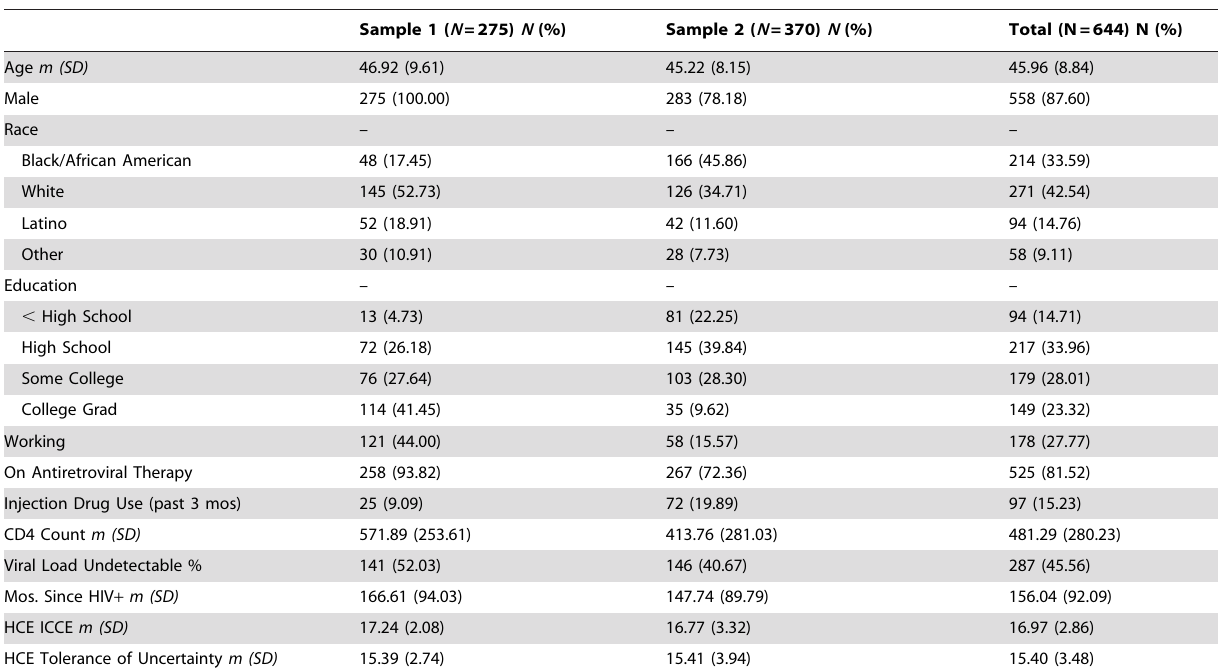
Table 1. Sample Characteristics.